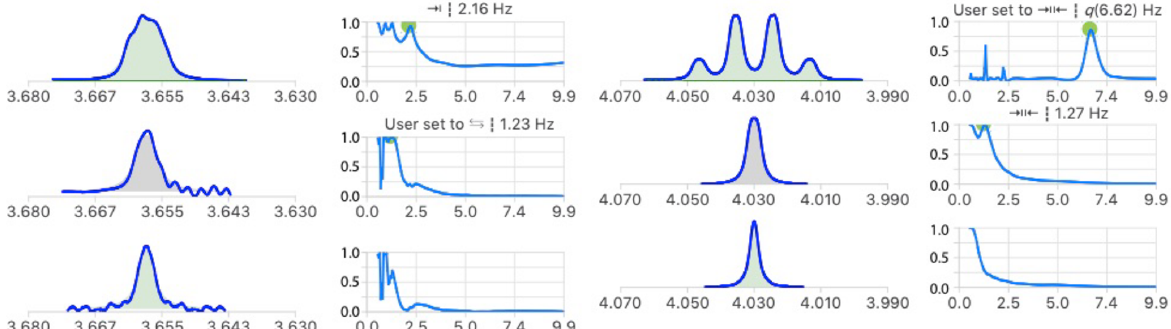
Figure 10. Extraction of unresolved coupling constants of the proton signals of C4 (left) and C5 (right) of a 6-deoxy-pyranose unit. The symbol indicates that symmetrization was not applied and deconvolution run from left to